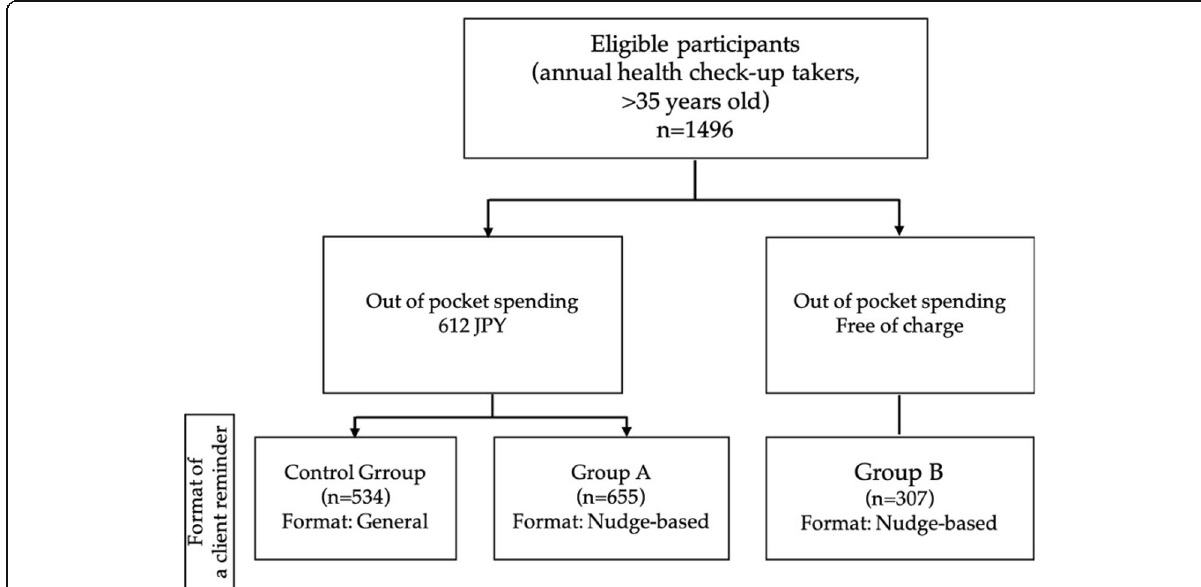
Fig. 1 Flow diagram of the trial process